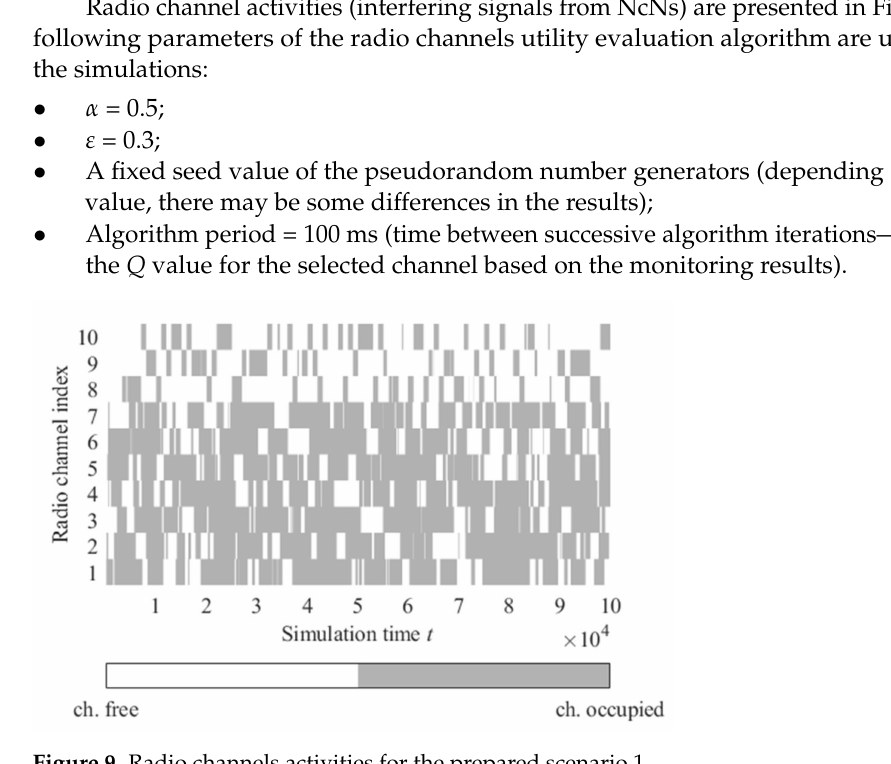
Figure 9. Radio channels activities for the prepared scenario